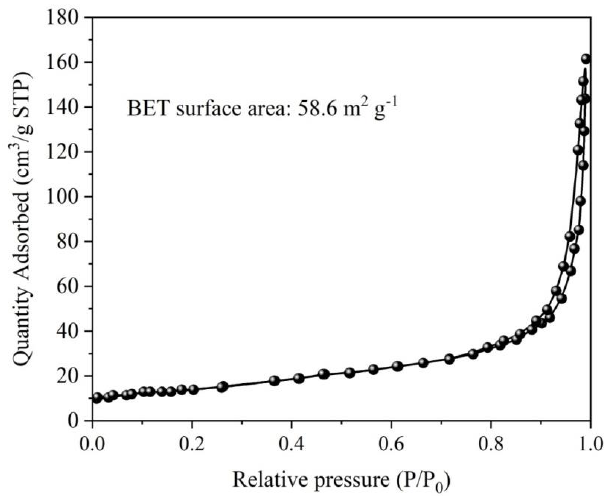
Figure 4. N 2 adsorption–desorption isotherm of TiO 2 nanoparticles.